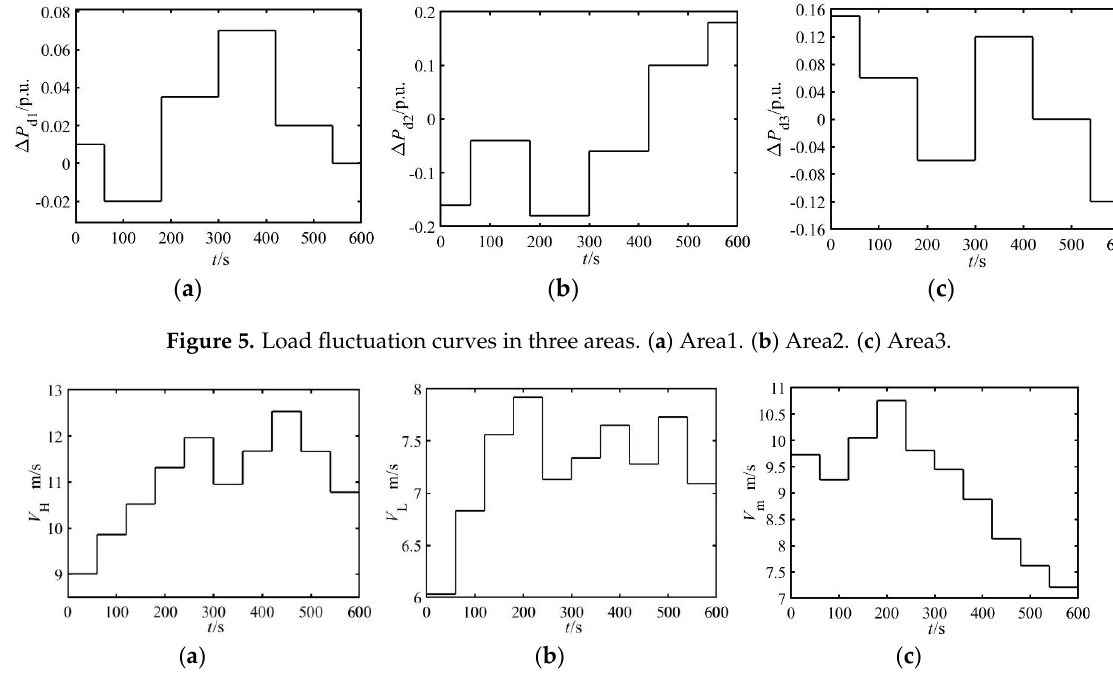
Figure 6. Wind speed fluctuation curve. ( a ) High wind speed in area1. ( b ) Low wind speed in area1. ( c ) Wind speed in area2.